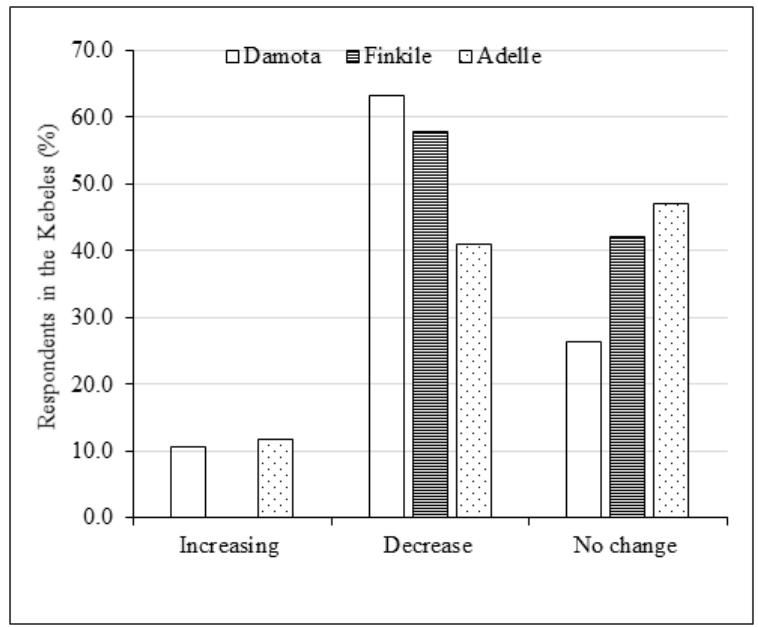
Figure 3. Crop yield trend within the last 10 years of the three selected kebeles of the Haramaya District (Source: Elaborated by the Authors).